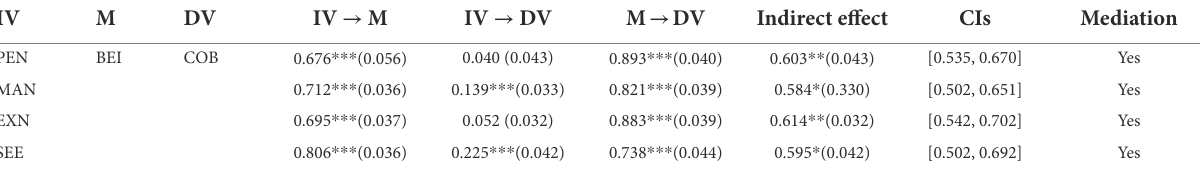
TABLE 7 Results of mediating effect analysis.